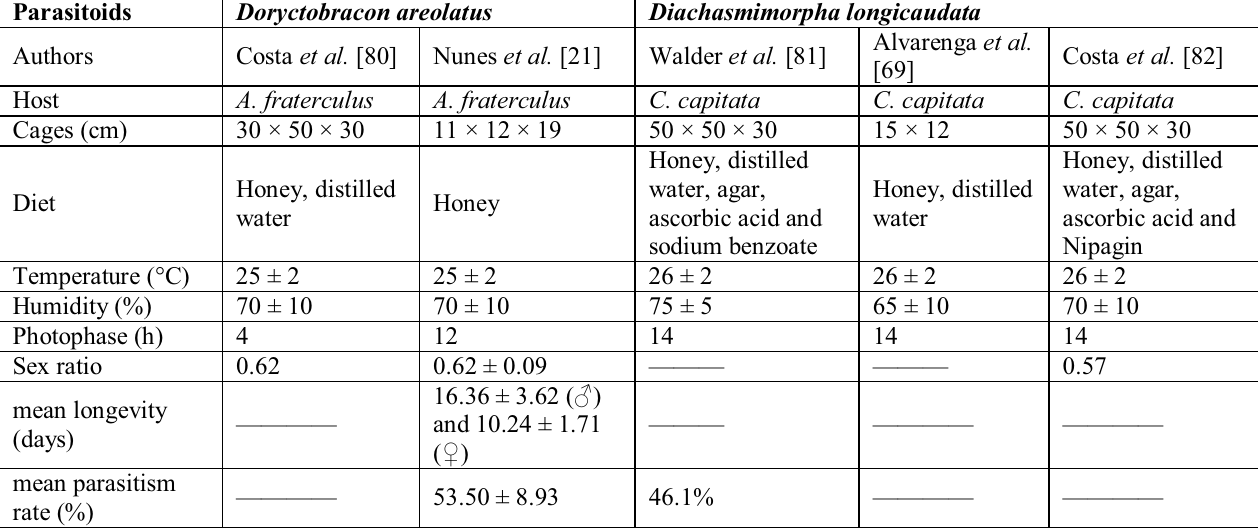
Table 2. Comparison between the rearing techniques of Doryctobracon areolatus and Diachasmimorpha longicaudata in